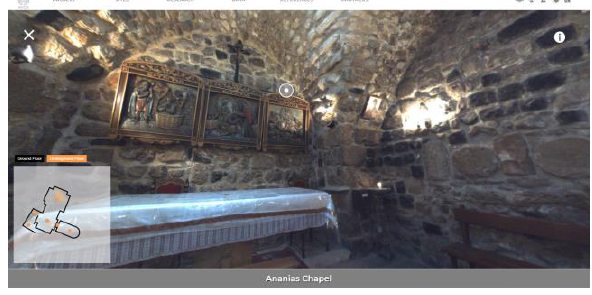
Figure 2. Ananias Chapel – Virtual Tour